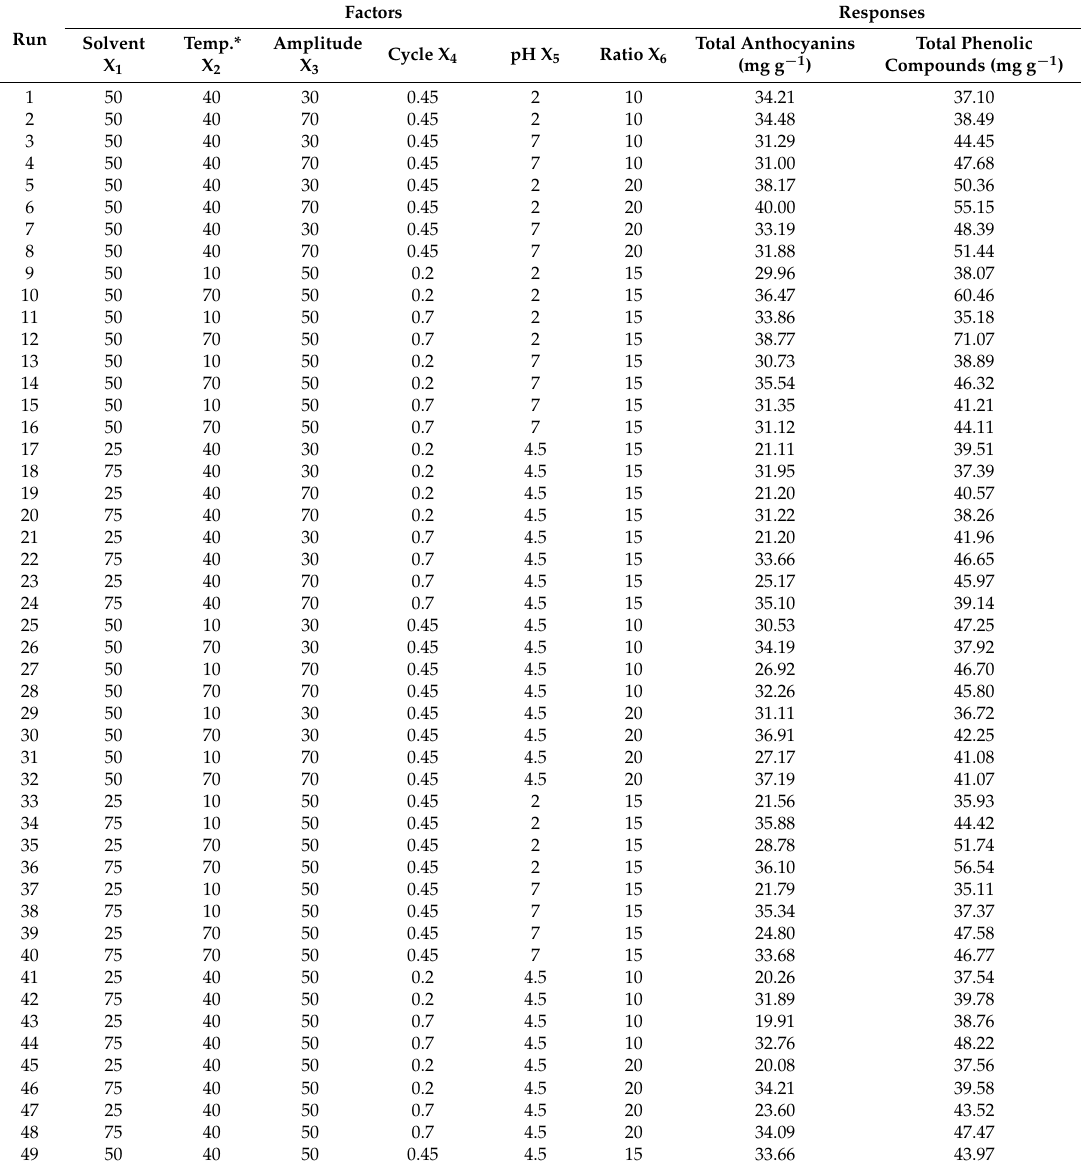
Table 1. Box-Behnken design matrix including both decoded variables and